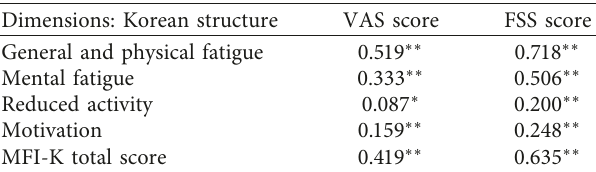
Table 5: Correlation between MFI-K and VAS score and FSS score in Korean factor structure.